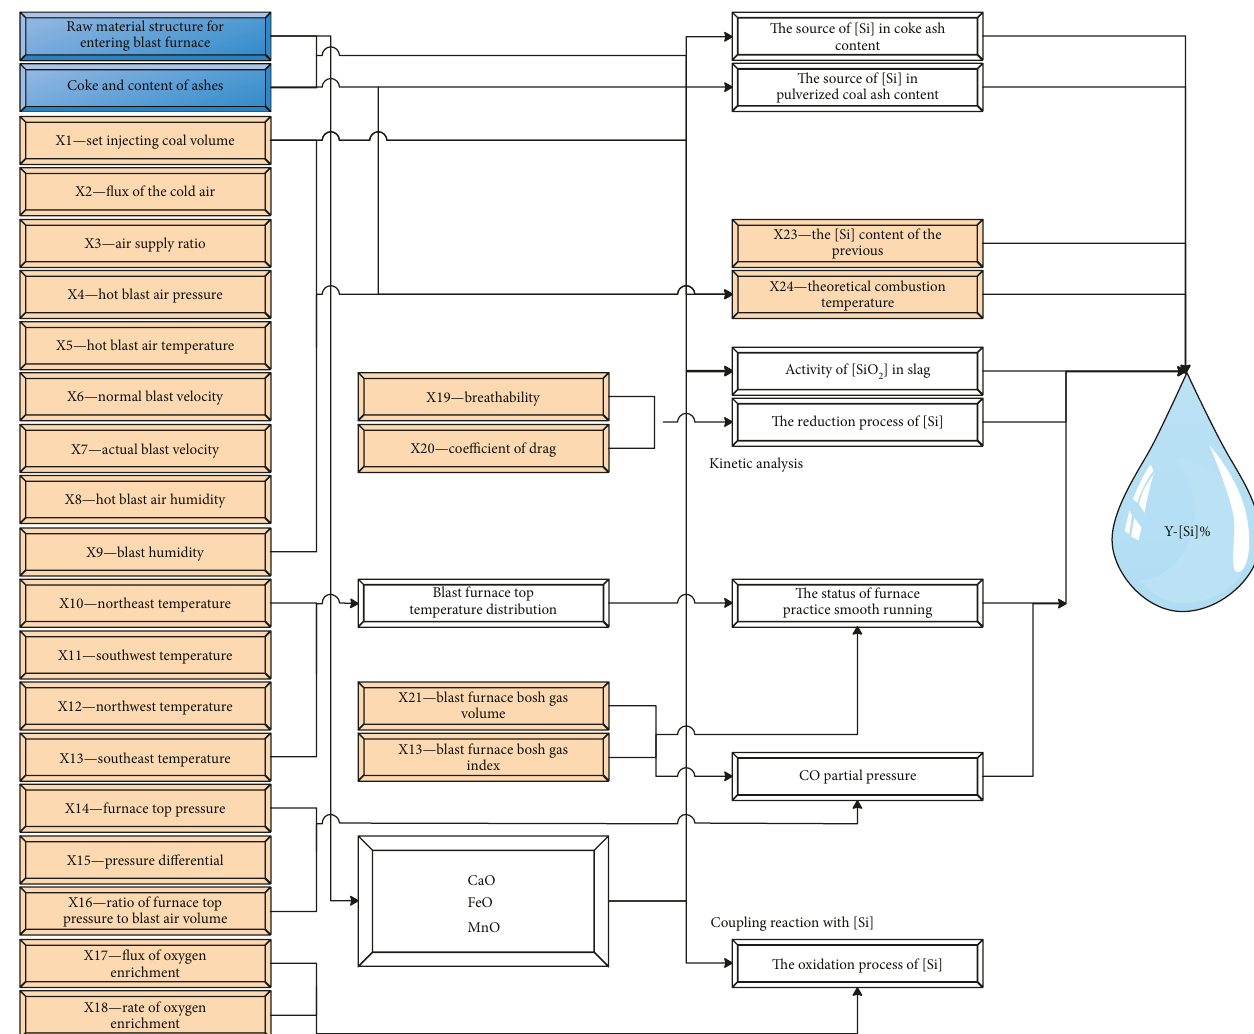
Figure 6: Action diagram of in fl uencing factors of [Si] content in molten